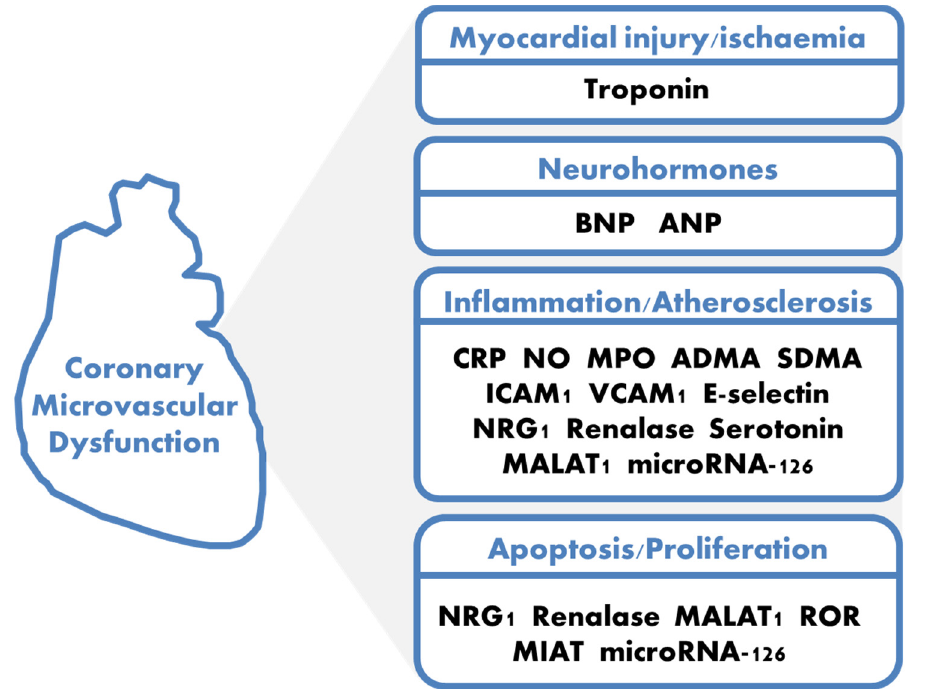
Figure 1. Coronary microvascular dysfunction traditional and novel potential biomarkers. ADMA= asymmetric dimethylarginine; ANP=atrial natriuretic peptide; BNP=brain natriuretic peptide; CRP=C-reactive protein; ICAM-1=intracellular adhesion molecules-1; MALAT1=metastasis-associate lung adenocarcinoma transcript 1; MIAT=myocardial infarction–associated transcript; MPO= myeloperoxidase; NO=nitric oxide; NRG1= neuregulin-1; ROR=regulator of reprogramming; SDMA=symmetric dimethylarginine; VCAM-1=vascular adhesion molecules-1.